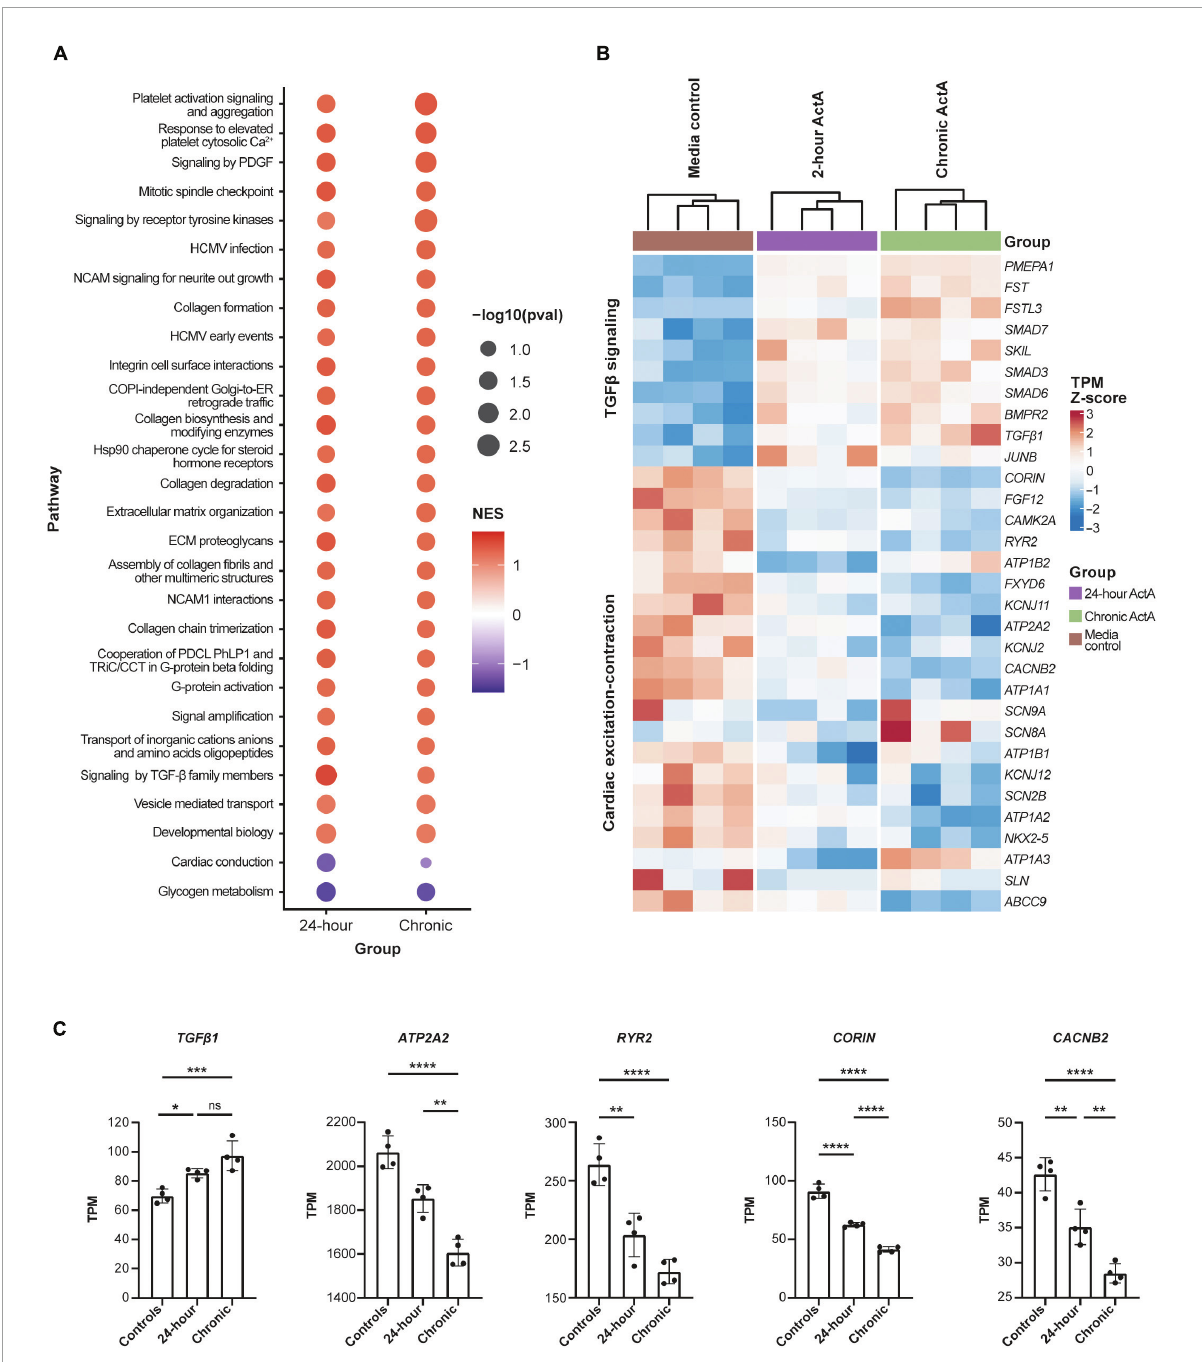
FIGURE5 Activin A–dependent gene signature in hiPSC-CMs. (A) Significantly enriched pathways in hiPSC-CMs treated with acute (24 h) and chronic Activin A. All pathways were upregulated with positive normalized enrichment scores except glycogen metabolism and cardiac conduction. Cardiac conduction and signaling by TGF- β family members were only significant ( P < 0.05) at 24 h. (B) Heatmap of leading-edge gene expression in cardiac conduction and signaling by TGF- β family members. Although both pathways were only significant after acute Activin A exposure (24 h), a similar pattern of gene expression was observed in chronic exposure. (C) TPM values for a subset of cardiac genes highlighted in the heat map. One-way ANOVA was used to determine significance. * P < 0.05, ** P < 0.01, *** P < 0.001, **** P < 0.0001. ActA, Activin A; hiPSC-CM, human-induced pluripotent stem cell-derived cardiomyocyte; ns, not significant; TGF- β , transforming growth factor- β ; TPM, transcripts per